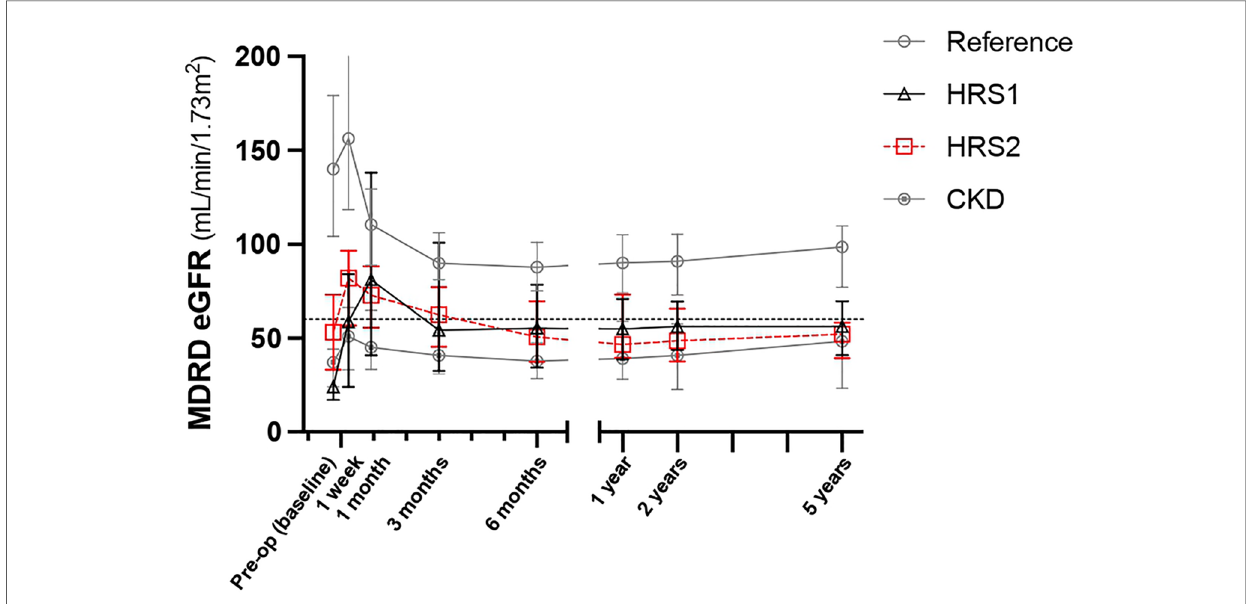
FIGURE 1 Serial change of eGFR in fi ve years after LDLT. Values are expressed as median±interquartile range. CKD, chronic kidney disease; eGFR, estimated glomerular fi ltration rate; HRS, hepatorenal syndrome; LDLT, living donor liver transplantation.